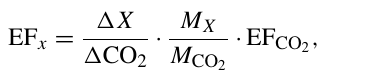
plement for more details). All analytes are also shown in Fig. 1: the flue gas analyser (Photon II) is aimed to test in- stantaneous emissions of gaseous pollution, including O 2 , NO 2 , NO, N 2 O, CO, CO 2 , and SO 2 (detection parameters for the gaseous matter are shown in Table S4). Three par- ticulate samplers are installed to collect PM using different filters at the same time, including a quartz fiber filter, glass filter, and polytetrafluoroethylene filter to analyse different chemical components of PM. And the portable TVOCs anal- yser is used to monitor the concentration of total VOCs with isobutylene as correction coefficient gas. Besides, a temper- ature sensor is installed near the smoke outlet to test the flue gas temperature. A total of 33 sets of samples for HH, 20 sets for DFH, and 23 sets for XYH were collected, with 3 to 5 sets for each operating